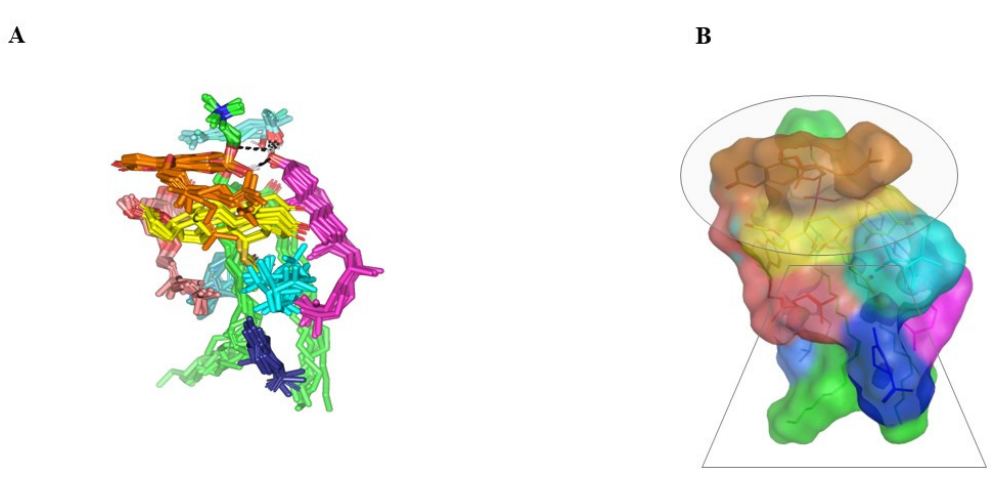
Figure 5. Dynamics of BEO-NPs-SP simulated formulation. ( A ) Overlay of BEO-NPs-SP complex across molecular dynamics simulation extracted frames over the initial docking conformation. ( B ) A 3D-molecular surface representation of the inverted cone micellar configuration at the end of the simulation run (1 ns). Molecules were shown in colors being previously assigned for the optimized formulation components: SP (yellow) loaded on PC interface (green), COL (magenta), LIN (faint blue), LIM (dark blue), GTP (marine blue), BPI (cyan), GMC (salmon), and BRG (orange).